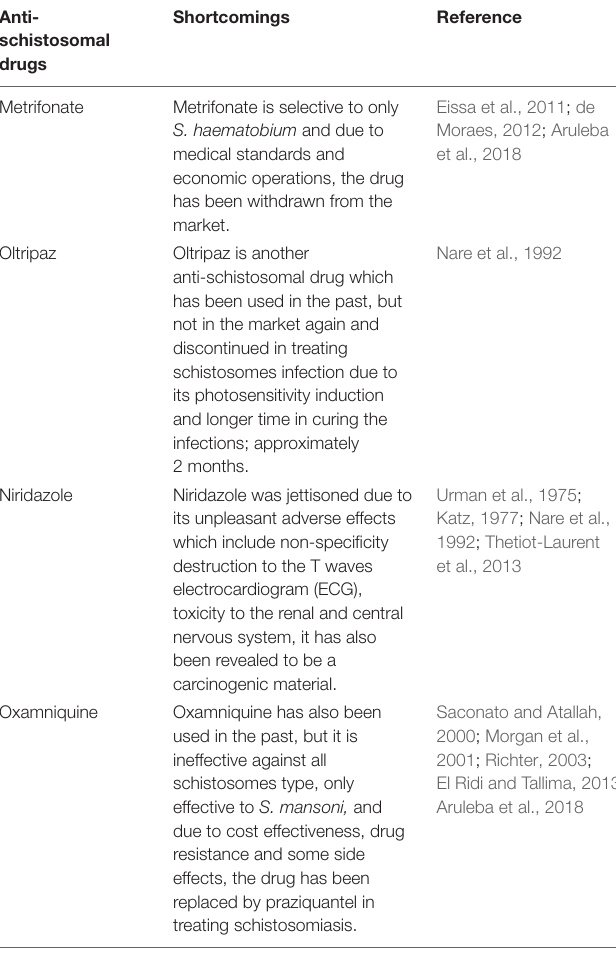
TABLE 1 | Drugs that have been used to treat schistosomiasis to date, with their shortcomings evaluated. Anti-